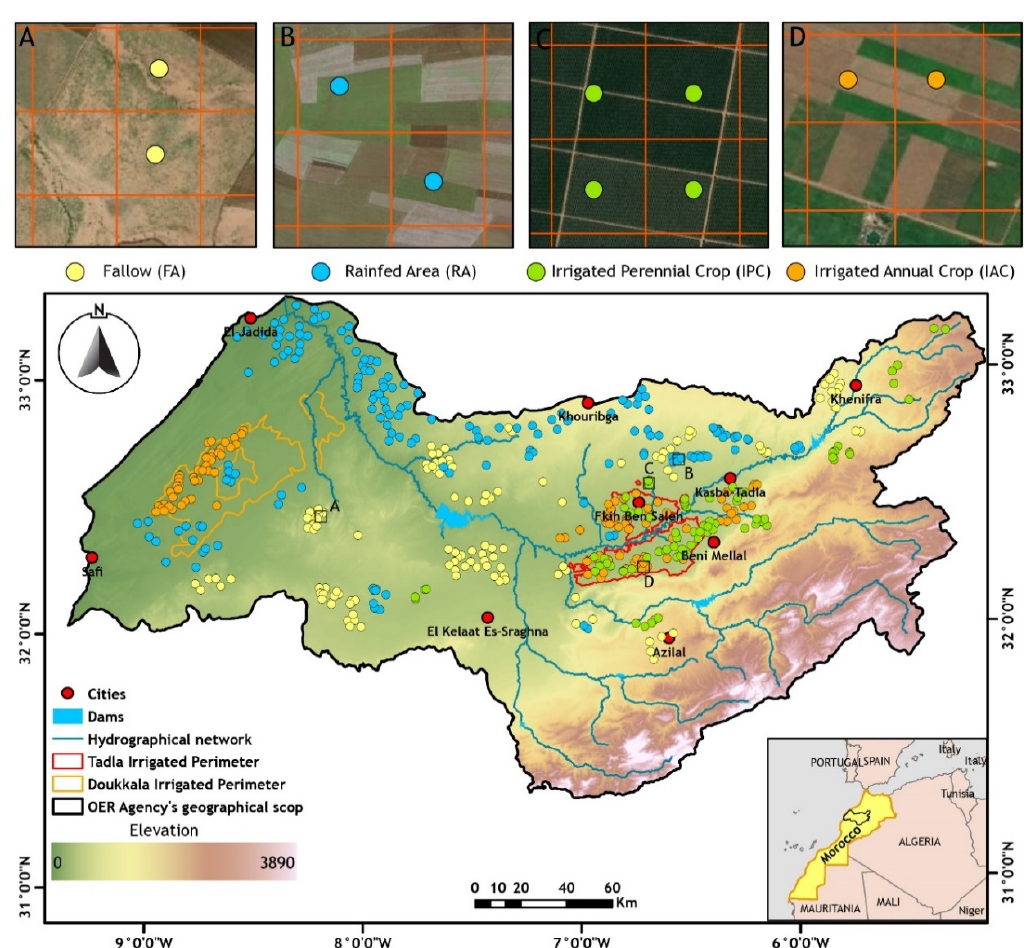
Figure 1. Map of the study area including the major irrigated areas (Tadla and Doukkala irrigated perimeters in red and orange, respectively) and the reference data localization: ( A ) fallow, ( B ) rainfed area ( C ) irrigated perennial crop and ( D ) irrigated annual crop. Colored points correspond to data used for training and validation of the Random Forest (RF) model.